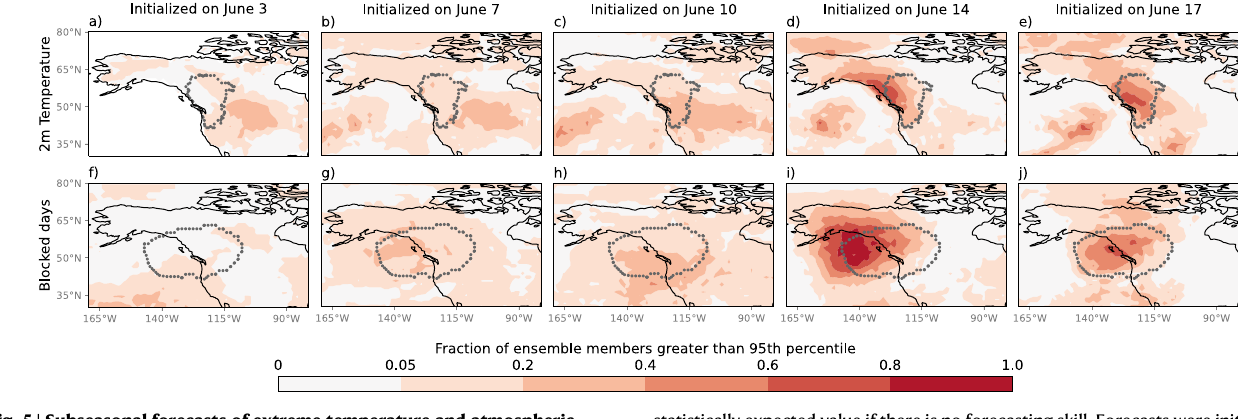
statistically expected value ifthereisno forecasting skill. Forecastswere initialized on 3 June ( a , f ), 7 June ( b , g ), 10 June ( c , h ), 14 June ( d , i ), and 17 June ( e , j ). Gray contours show the observed location of the heatwave based on ERA5 2m temperature